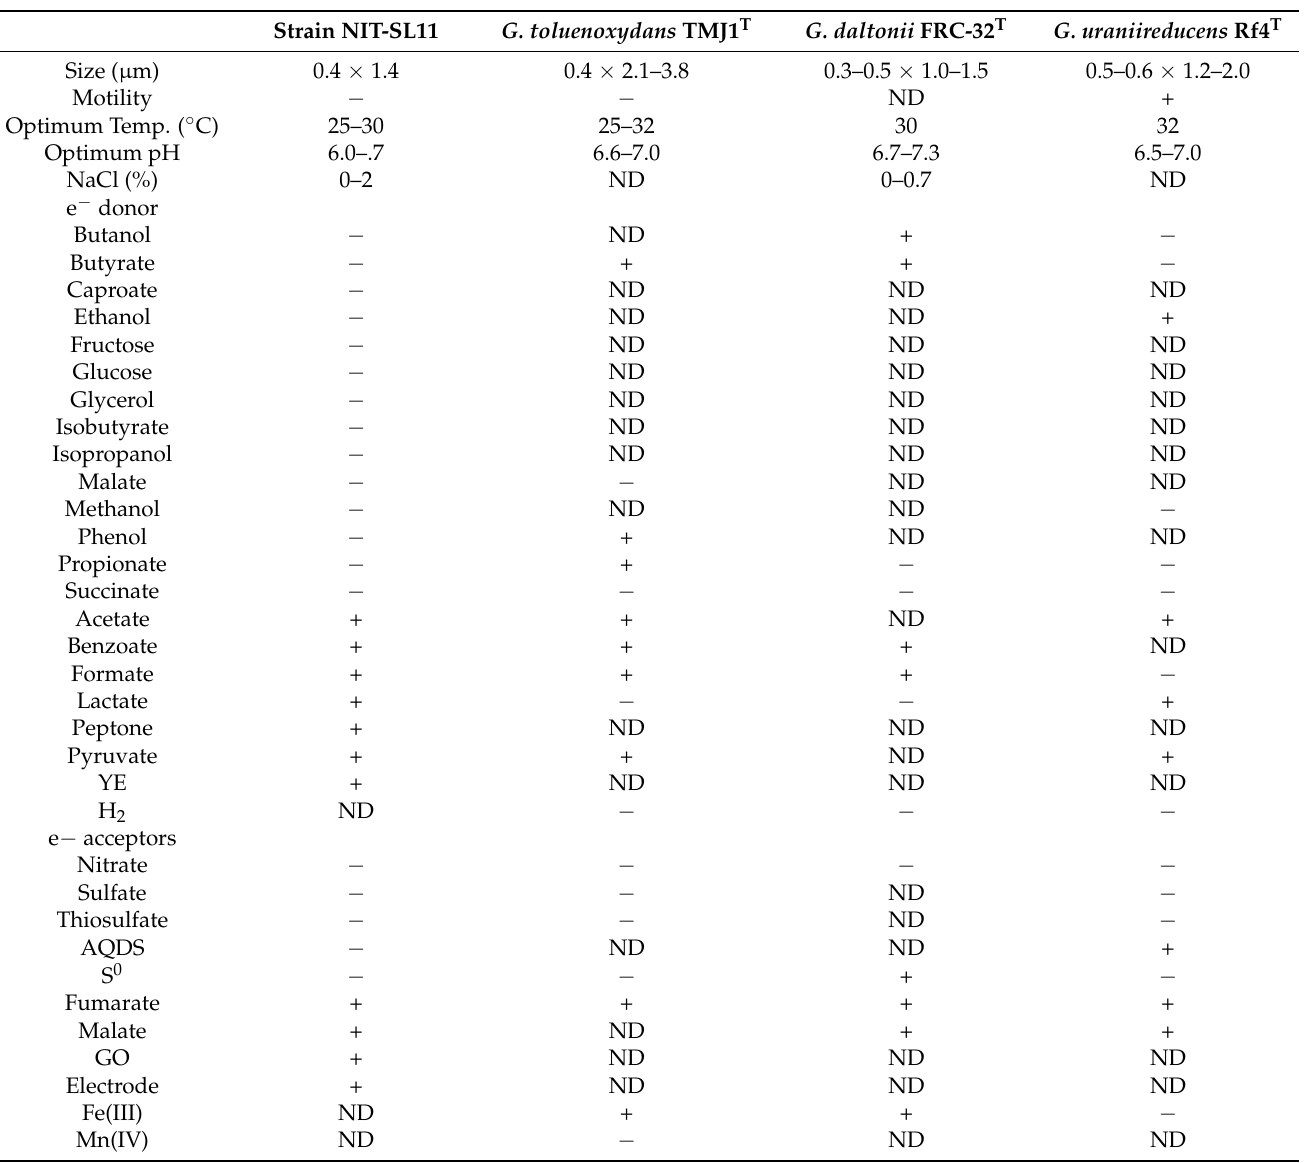
Table 1. Comparison of morphological and physiological properties of strain NIT-SL11 and